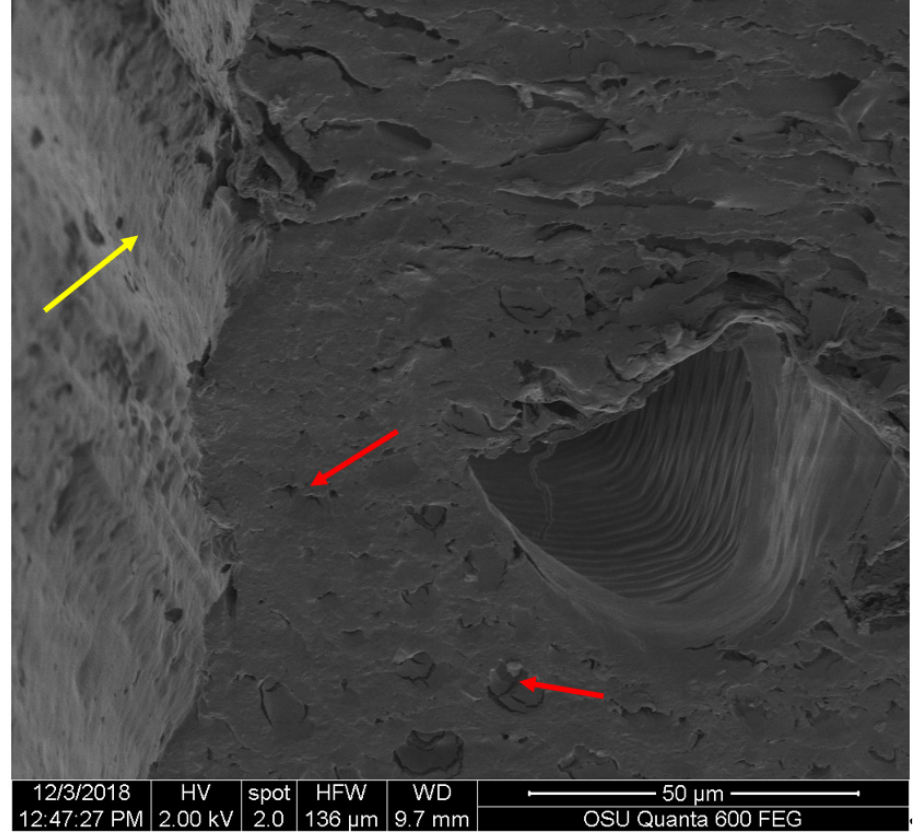
Figure 3. Scanning electron microscopy of sugar maple finished with one coat of linseed oil. The yellow arrow points at the general appearance of the wood, which is smoothed over from the oil coatings. The red arrows point to dried oil in the cell lumens, which blocks the flow of water (and bacteria).